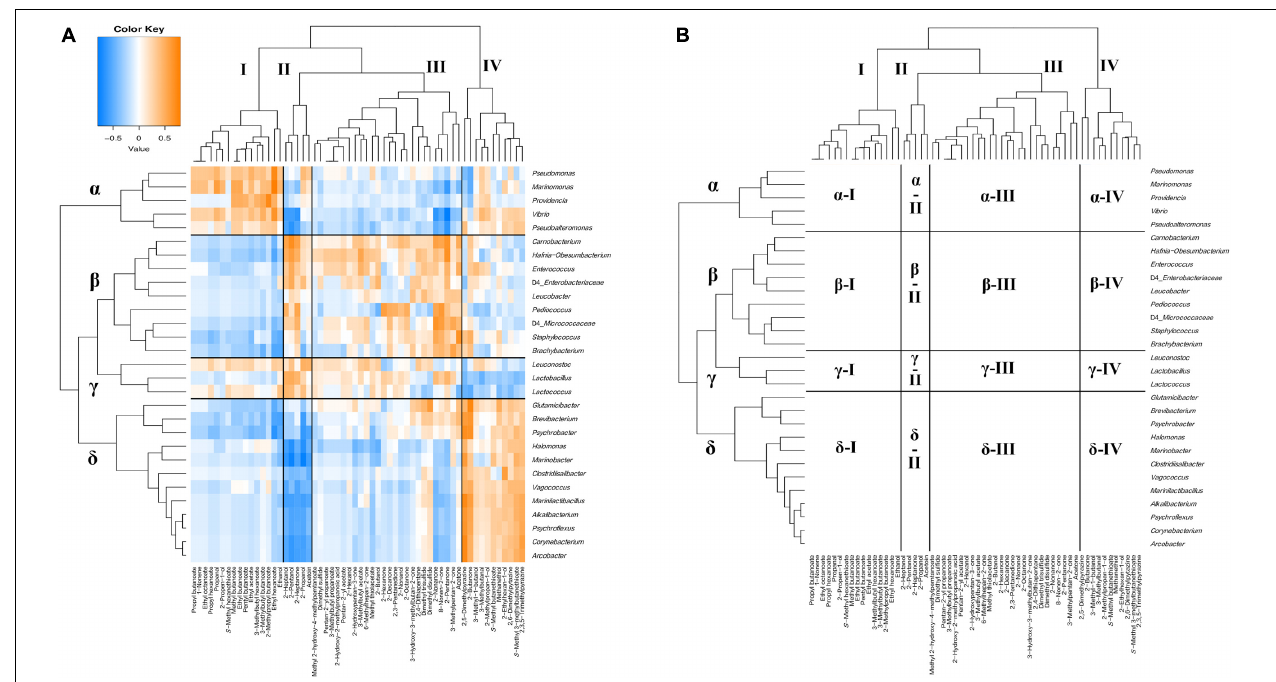
FIGURE 11 | Hierarchical clustered map showing the Spearman correlation between bacteria genus and volatile compounds detected on 30 cheese samples. (A) Spearman correlation heat map. Orange indicates positive correlation and blue indicates negative correlation. (B) Hierarchically clustered map. Volatile compounds clusters are represented by I, II, III, and IV. Bacteria clusters are represented by α , β , γ , and δ